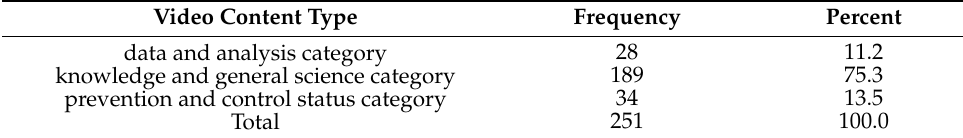
Table 7. Distribution of content types of COVID-19 videos.